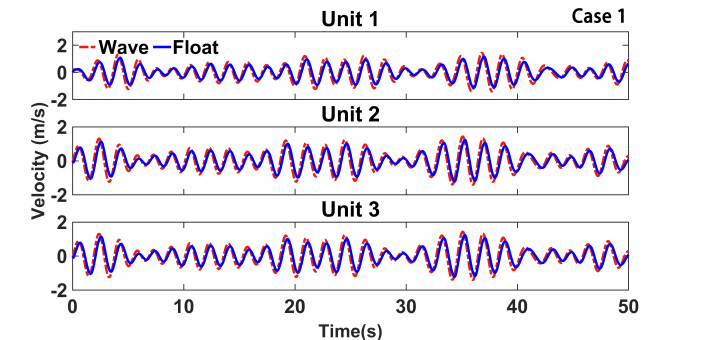
Figure 6. Buoy velocity and incident wave